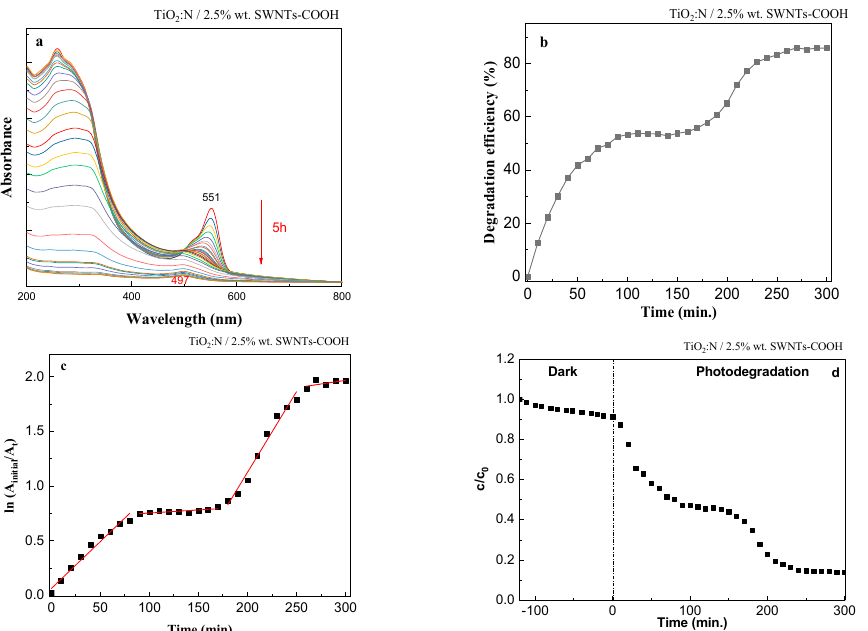
Figure 12. UV–VIS absorption spectra of the RhB aqueous solution containing the SC sample, recorded by the successively exposure to UV light, time of 300 min (5 h) ( a ), the degradation efficiency as a function of the UV irradiation time ( b ), and the reaction kinetics ( c ). Photocatalytic degradation of RhB solution in the presence of the SC sample and UV light ( d